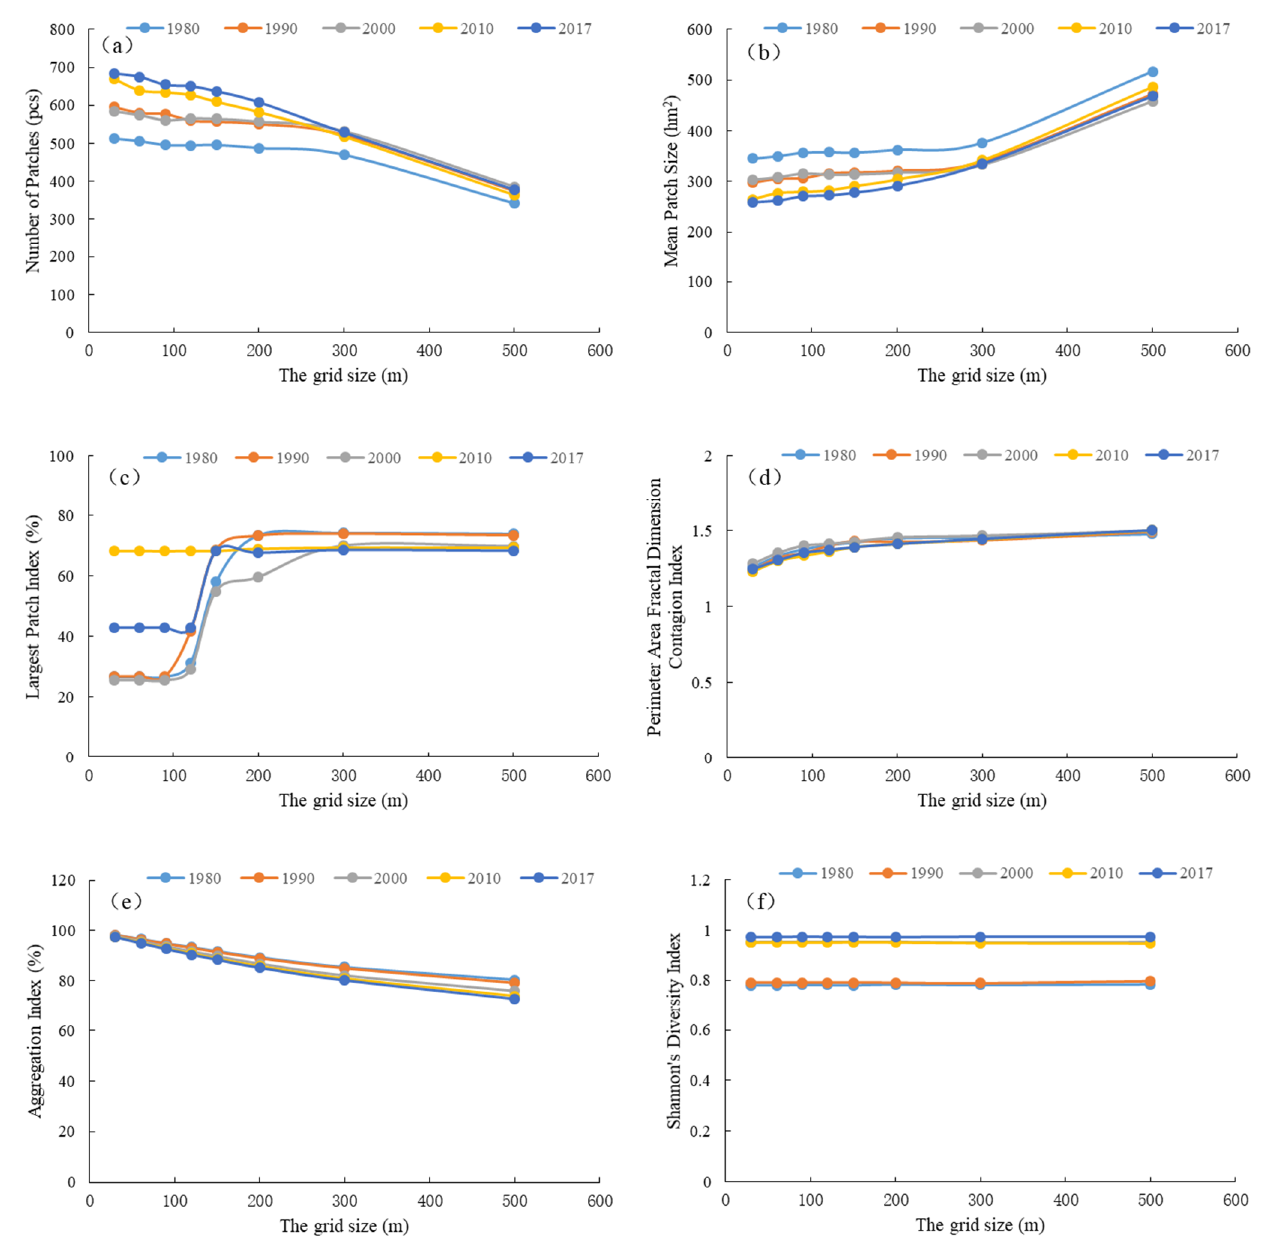
Figure 5. The relationship between the landscape pattern indexes of the Xiong’an New Area and its grid size. ( a ) NP, ( b ) MPS, ( c ) LPI, ( d ) PAFRAC, ( e ) AI, and ( f ) SHDI.